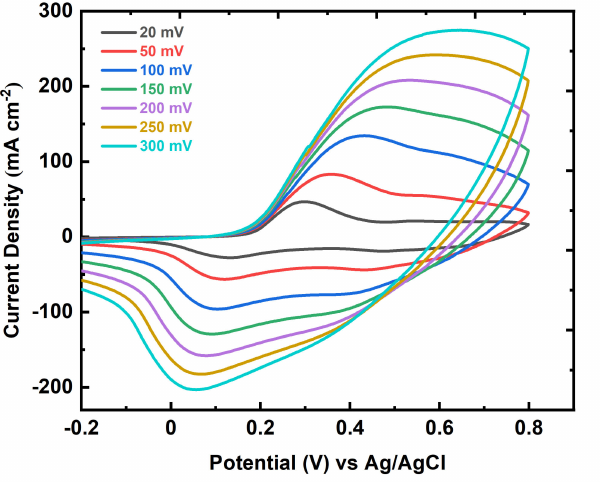
Figure 6. Cyclic voltammogram FTO-PANI in 1 M H 2 SO 4 vs Ag/AgCl (KCl sat in H 2 O) at various scan rates.